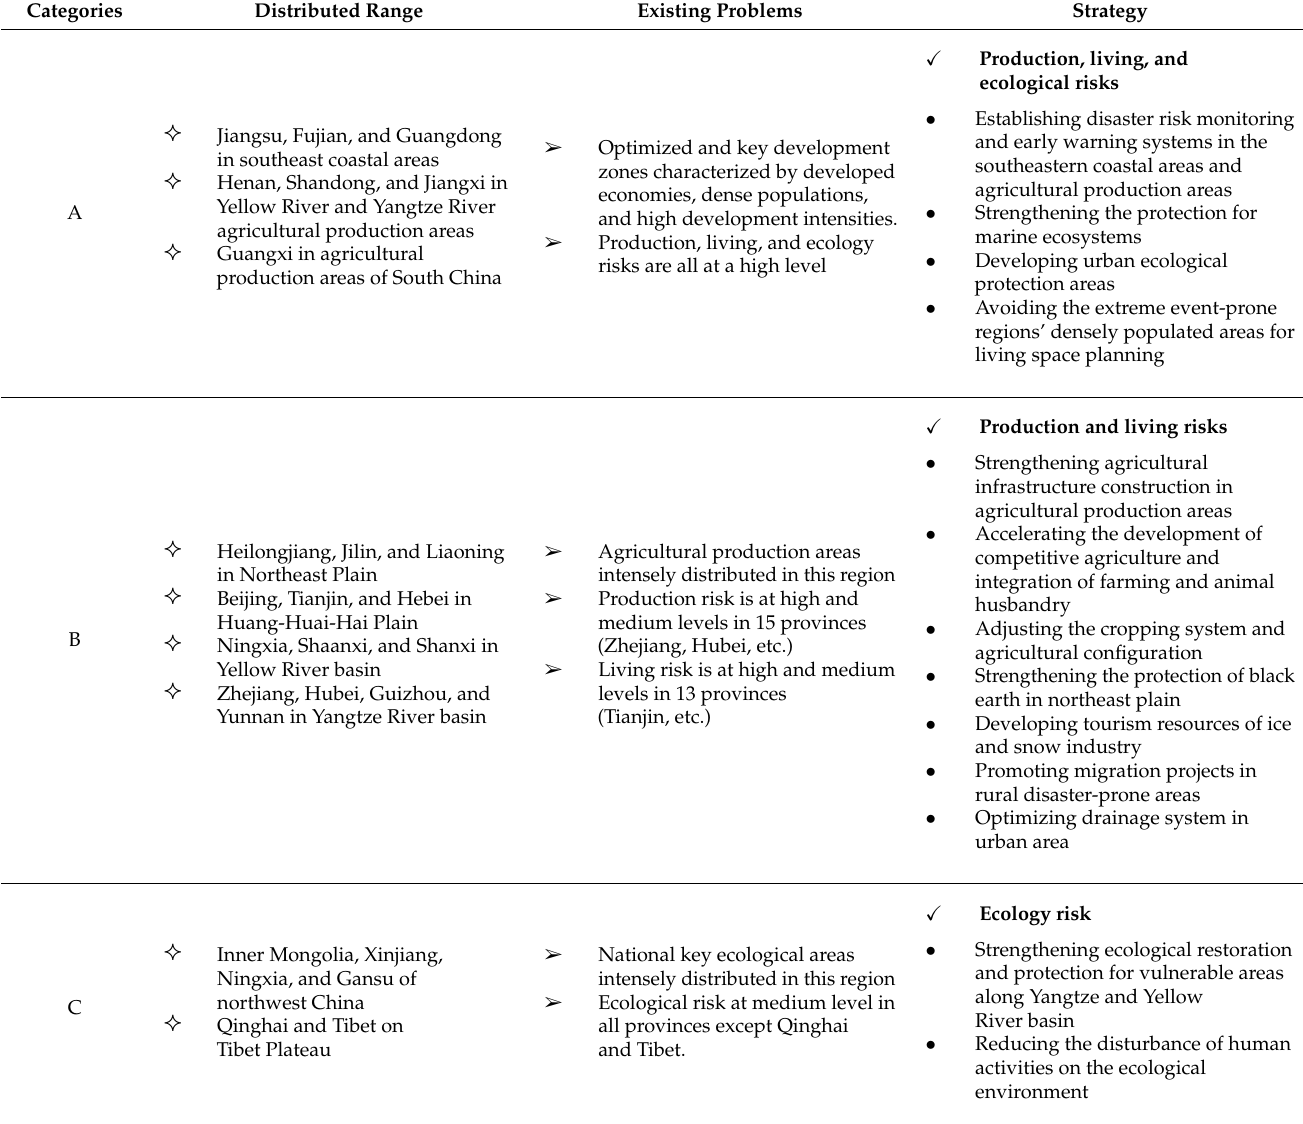
Table 3. Strategy to cope with PLE risk under climate change scenario.